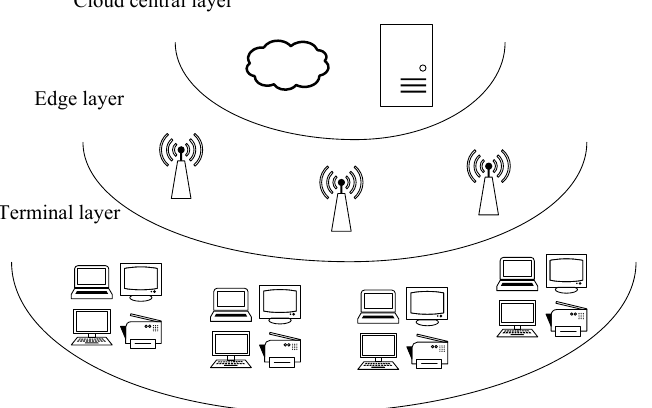
Figure 4. DDoS attack detection network architecture diagram based on edge computing.